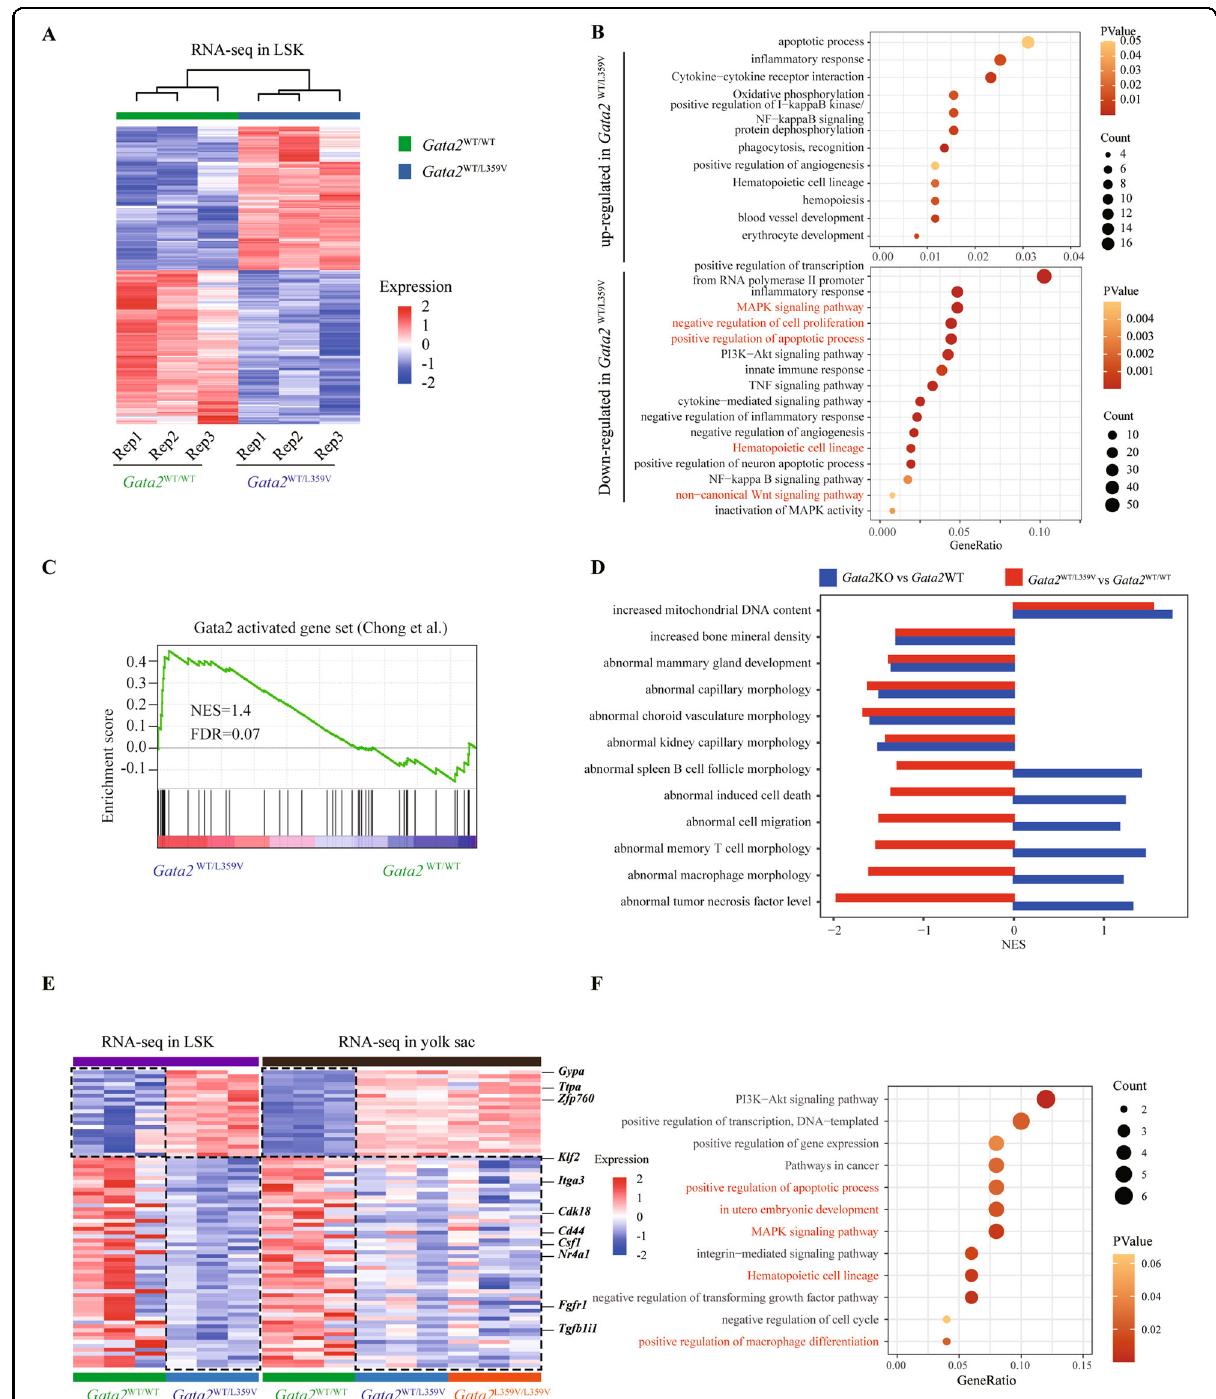
Fig. 4 Molecular defect of Gata2- L359V in de fi nitive hematopoiesis. A Heatmap showing the differentially expressed genes in the LSKs of Gata2 WT/ L359V as compared with Gata2 WT/WT group. Every sample was comprised of an LSK mixture from three mice of the same genotype. B GO analysis of genes up/down-regulated in Gata2 WT/L359V compared to Gata2 WT/WT LSKs. C Gene set enrichment analysis (GSEA) of Gata2 activated gene set in Gata2 WT/L359V vs Gata2 WT/WT LSKs. D Enrichment analysis of gene sets of mammalian phenotype ontology in Gata2 KO vs Gata2 WT or Gata2 WT/L359V vs Gata2 WT/WT . E Heatmap showing genes differentially expressed between Gata2 WT/L359V and Gata2 WT/WT in both yolk sacs and LSKs. F GO analysis of genes down- regulated in Gata2 WT/L359V vs Gata2 WT/WT in both yolk sacs and